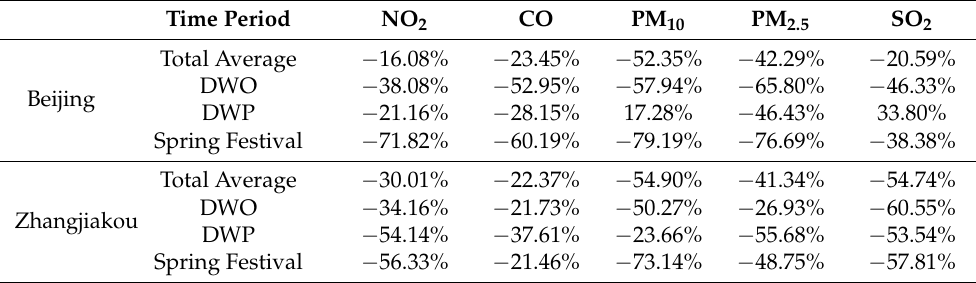
Table 1. Estimated decreases in pollutant concentrations in Beijing and